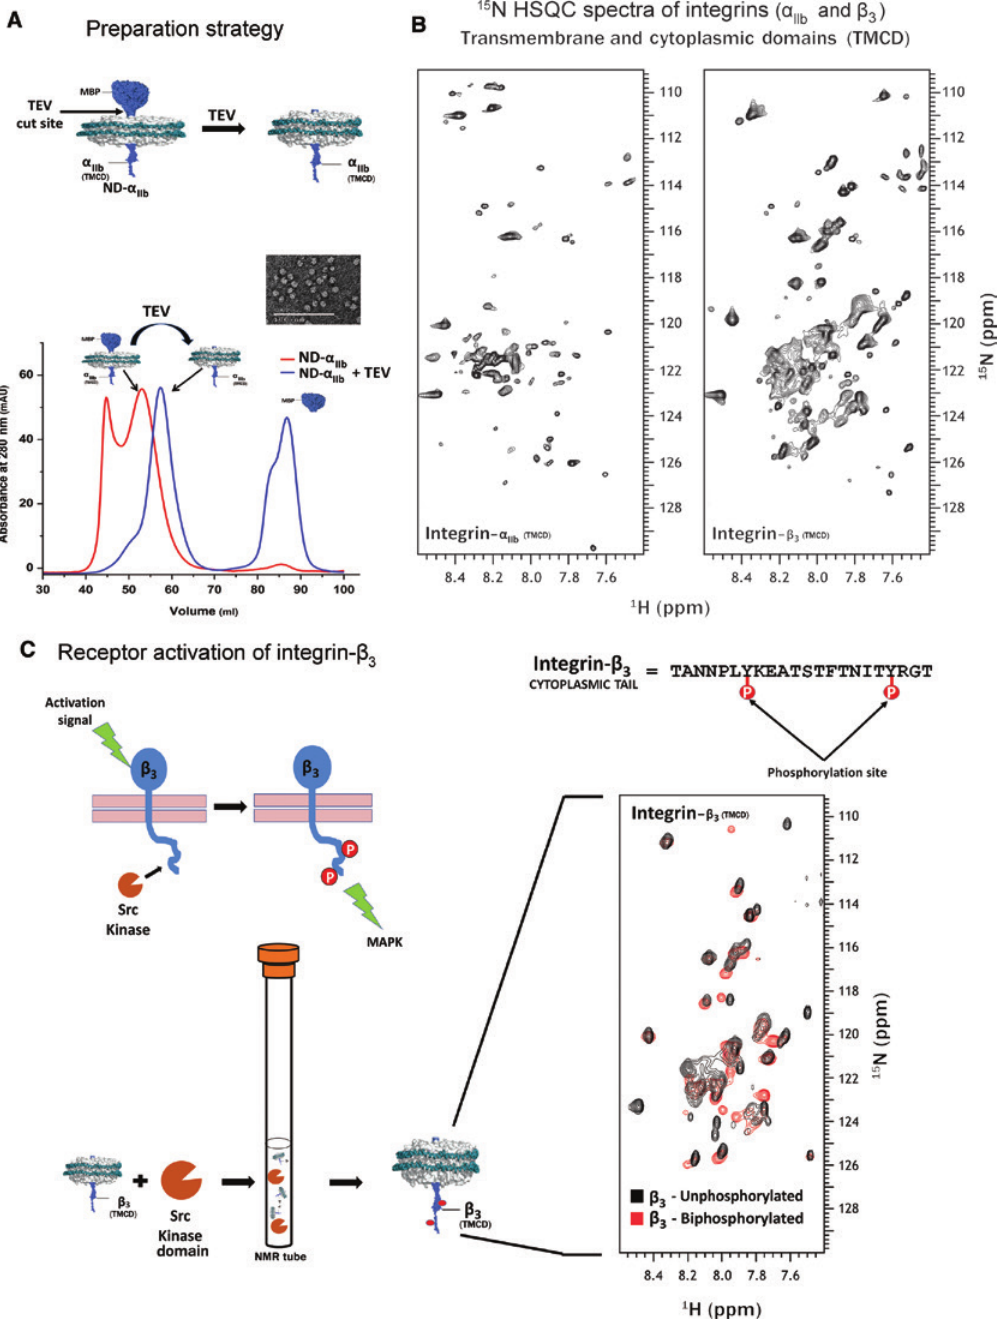
[trans-membrane and cytoplasmic domains (TMCD)] incorporated nanodisc. Figure 4: (A) Overview of the procedure to obtain integrin α IIb TEV protease treatment of MBP-integrin α (TMCD) incorporated nanodisc, cleaves the MBP–tag at the TEV cleavage site engineered IIb between the tag and Integrin. The α incorporated disc can then be purified from the rest of the cut products using SEC. Inset: negatively IIb stained TEM image of α containing nanodiscs displaying a homogeneous population. The exact same procedure can also be extended to IIb obtain β (TMCD) incorporated nanodisc. (B) 1 H- 15 N- TROSY HSQC spectra of Integrin α and β (TMCD) acquired on 800 MHz magnet. The 3 IIb 3 sharp peaks correspond to the cytoplasmic tail region while the broader peaks correspond to the transmembrane region. (C) Applicability of nanodisc systems for studying signaling pathways. A schematic showing the activation events of Integrin β relayed intracellularly through 3 the phosphorylation of its cytoplasmic tail by Src kinase (top panel). This event is mimicked (in vitro) within an NMR tube by mixing 15 N labeled β incorporated discs with the kinase domain of Src kinase in the presence of ATP molecules. Phosphorylation is manifested through 3 chemical shift perturbations observed through the overlay of the 1 H- 15 N-TROSY HSQC spectra obtained from un-phosphorylated (black) and bi-phosphorylated (red) β (TMCD) collected on 600 MHz magnet. Also shown is the sequence of the β tail highlighting the tyrosine resi- 3 3 dues involved in